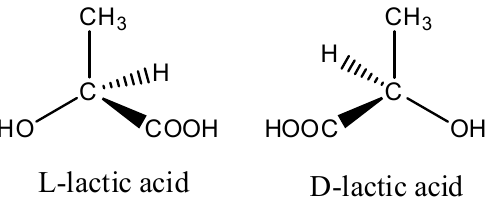
Figure 2. Isomeric forms of lactic acid L and D.